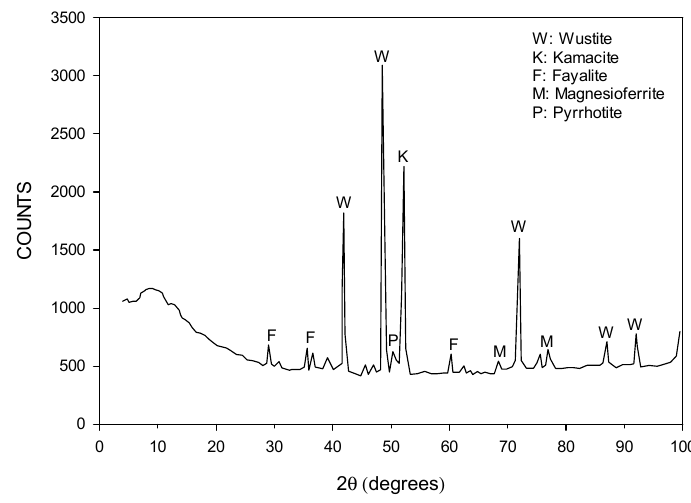
Figure 16. X-Ray Diffraction pattern of a reduced briquette at 600 °C with a thermal growth temperature of 1100 °C.